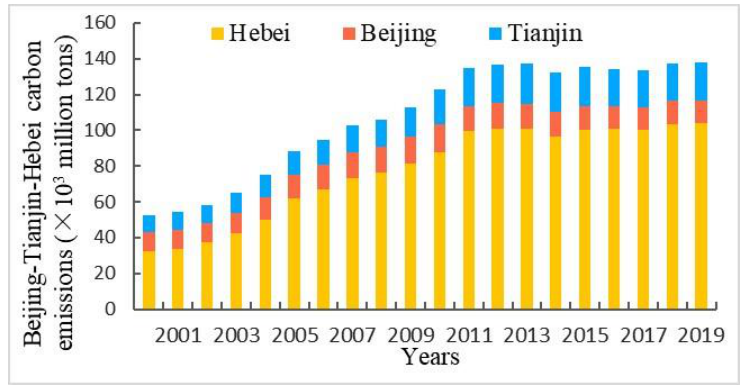
Figure 7. Beijing – Tianjin – Hebei carbon emissions from 2000 – 2019. Figure 7. Beijing–Tianjin–Hebei carbon emissions from